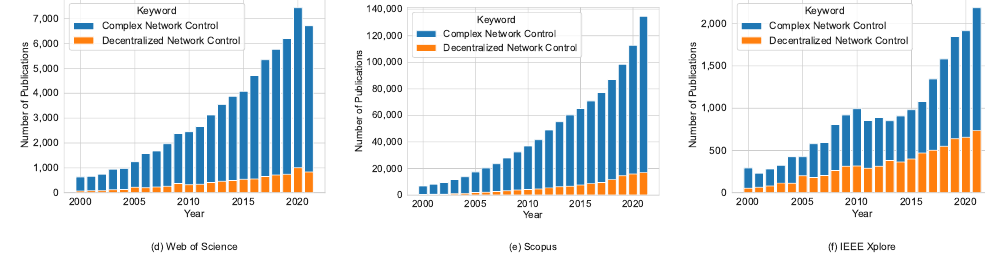
Figure 1. Total number of “Network Science” related publications over time from 2000 to 2021. Table 1. Network-Science-related publications on the Web of Science, Scopus, and IEEEXplore from 2000 to